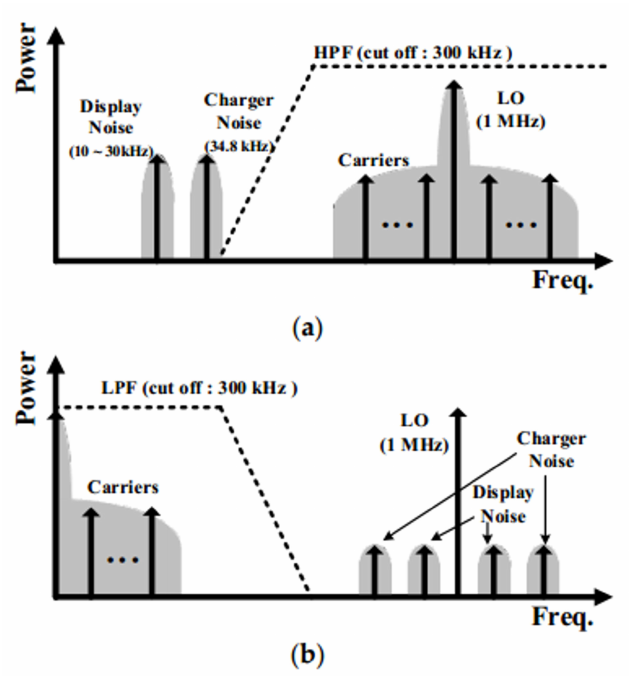
Figure 4. Spectrum of the touch signal and noises ( a ) before down-conversion and ( b ) after